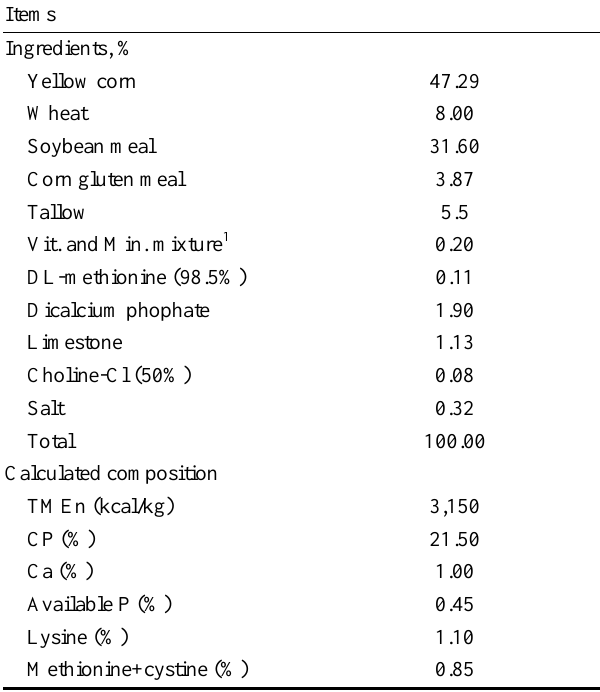
Table 1. Formula and chemical compositions of the